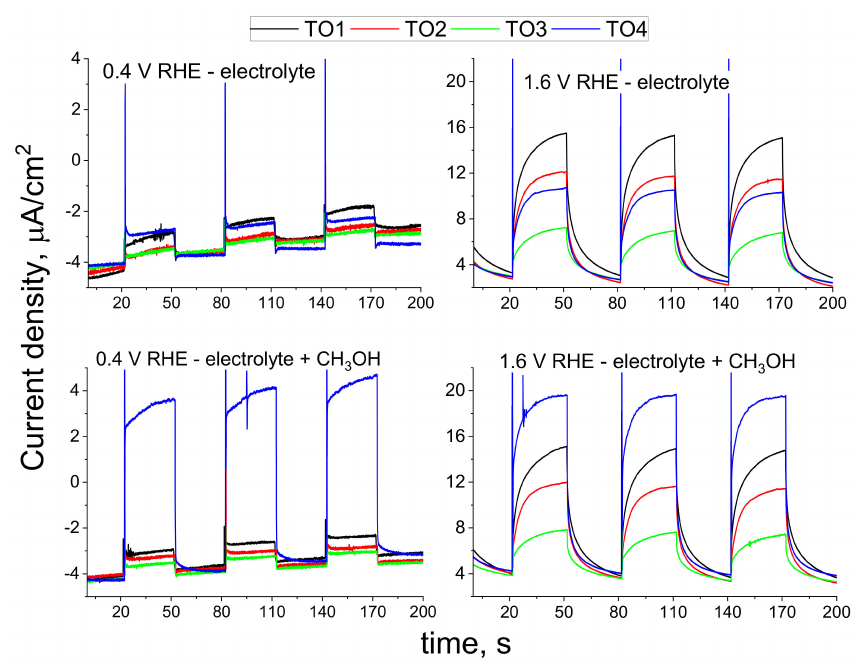
Figure 7. Time dependence of current density in TO1–TO4 at periodical illumination: 0.4 V (left) and 1.6 V (right) without (upper plots) and with methanol addition (bottom plots). Low photocurrents are characteristic of TO1–TO3 at cell potential 0.4 V but